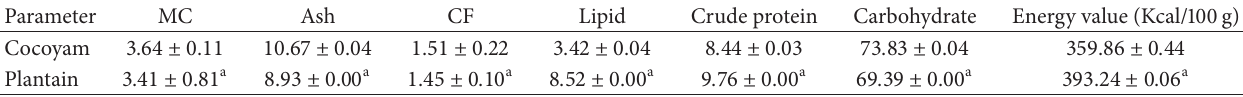
a 𝑃 < 0.05 versus cocoyam feed; MC: moisture content; CF: crude